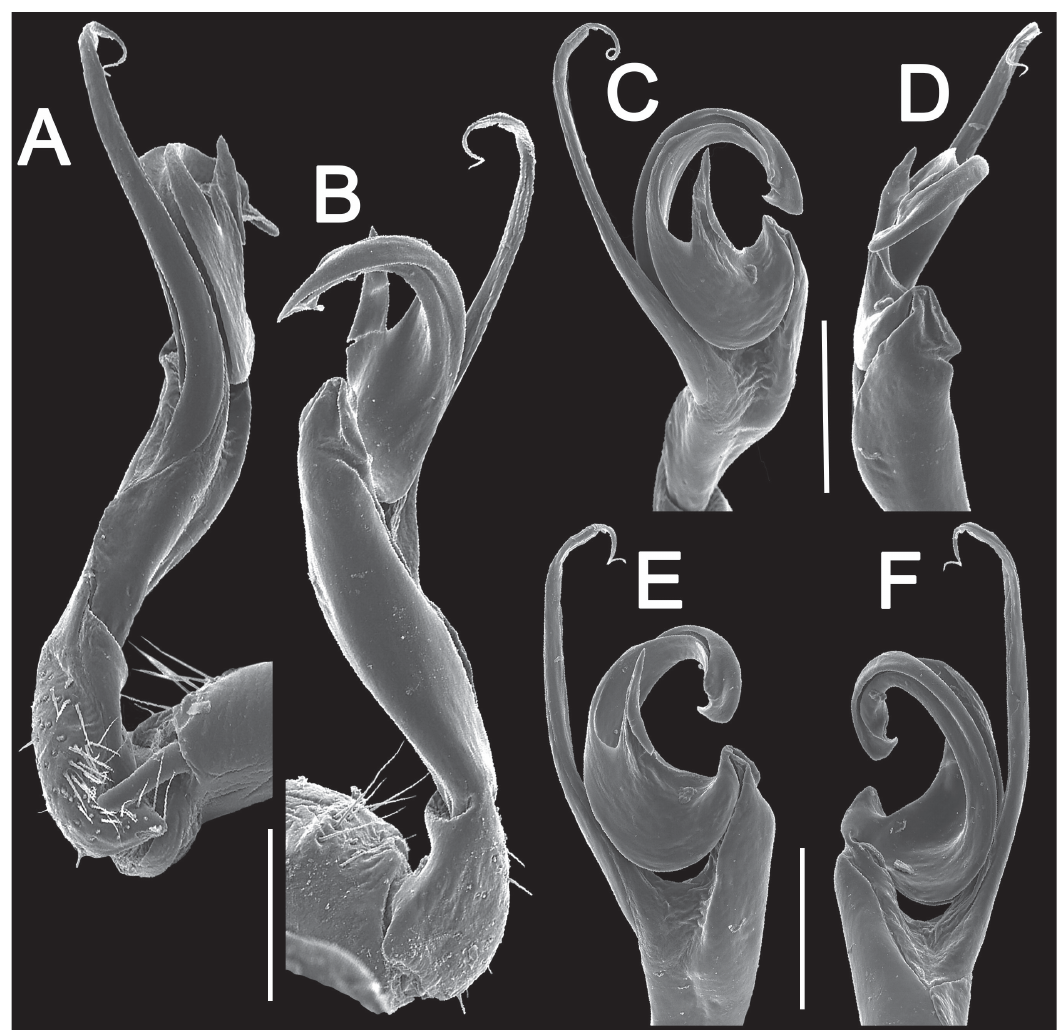
Fig. 3. Tylopus flavolineatus sp. nov., holotype, ♂, right gonopod. A–B . Mesal and lateral views, respectively. C–F . Distal part, subcaudal, subcaudal, suboral and sublateral views, respectively. Scale bars = 0.2